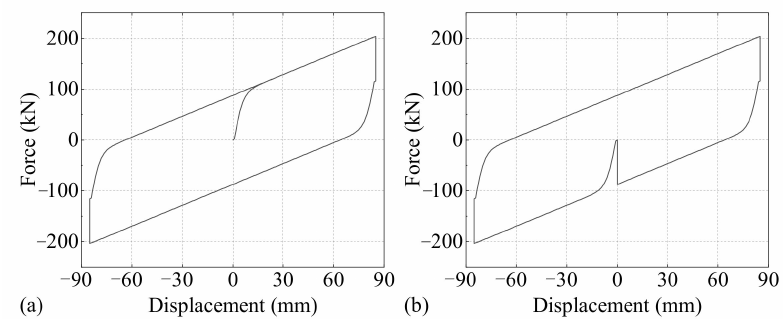
Figure 8. The restoring force–displacement relationship of the isolation bearing model. ( a ) X-direction. ( b )